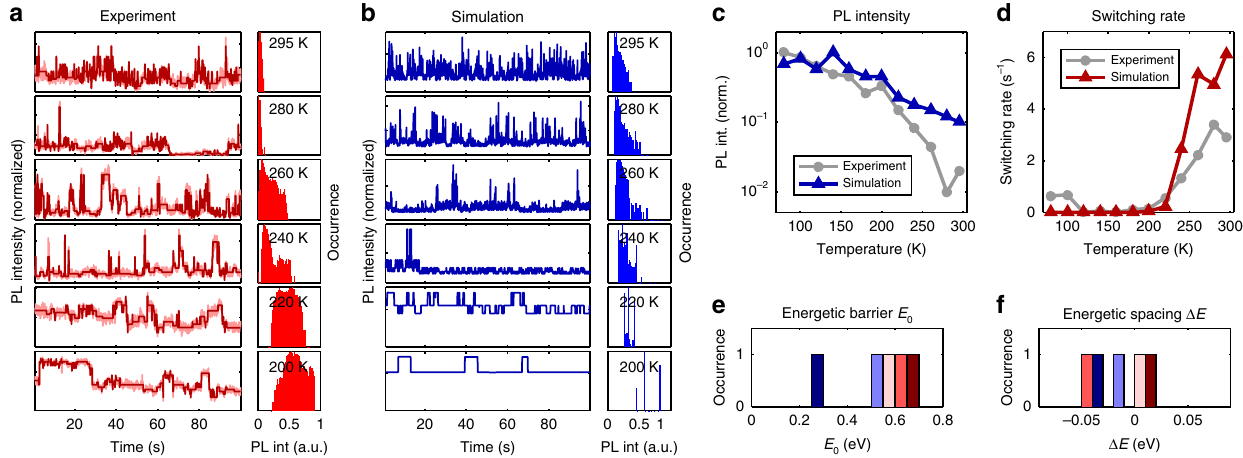
Fig. 6 Simulated blinking transients and comparison to the experimental data for one crystal (#110). Panel a shows normalized experimental intensity transients recorded at various temperatures with the corresponding intensity histograms in the right column. The dark red curves were created from the raw data using the Bayesian method (see Methods) and served for further analysis of the blinking behavior. In panel b we show simulated intensity transients created from our model. Here we chose fi ve quenchers and adjusted the energies of the individual quenchers E 0 and Δ E , such that the resulting intensity curves mimic the experimental observations for this crystal (see Supplementary Figures 6 – 8 for more examples). Panels c and d show the PL intensity and the switching rate (number of switches per second) extracted from the experimental and simulated data. In order to provide an overview over the energetics of the simulated quenchers, we plot histograms of the minimum energetic barrier E 0 and the energetic spacing Δ E ¼ E p (cid:3) E a in panels e and f ,